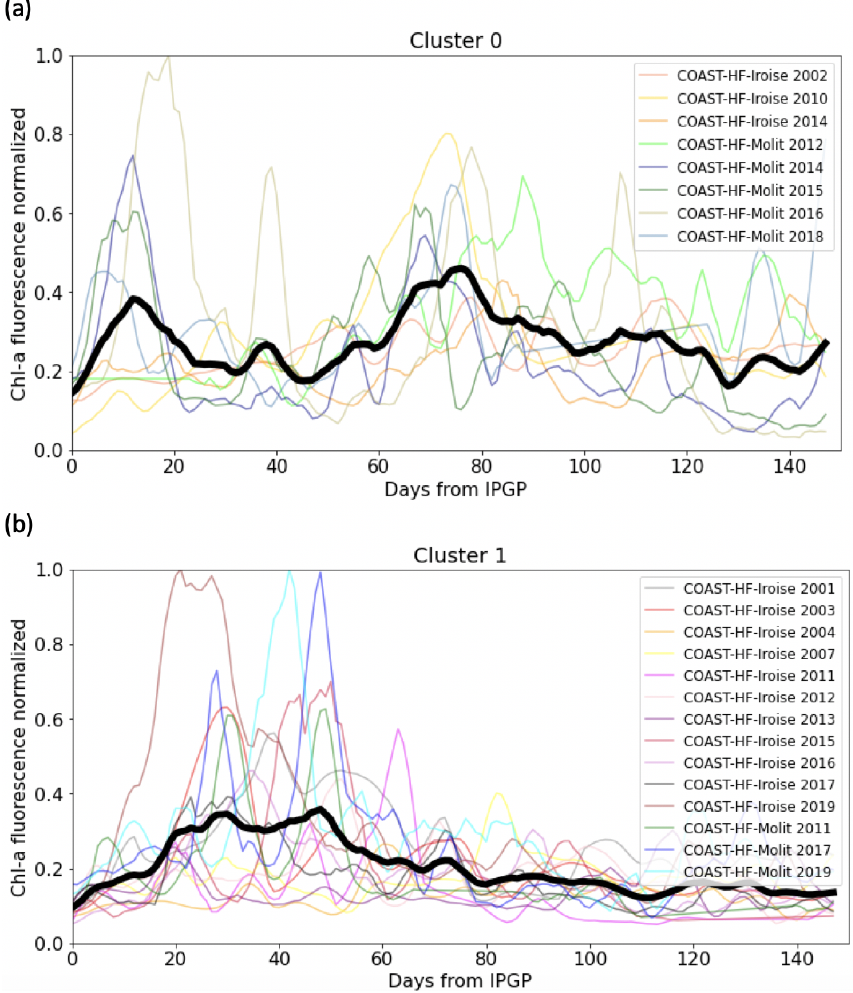
Figure 5. (a) Cluster 0 and (b) cluster 1 representative of the patterns of the phytoplankton growing period observed in both bays. The median pattern is drawn in bold. Table 4. Characteristics of environmental drivers at the date of the IPGP except for nutrients from January to March in the Bay of Brest and in the Bay of